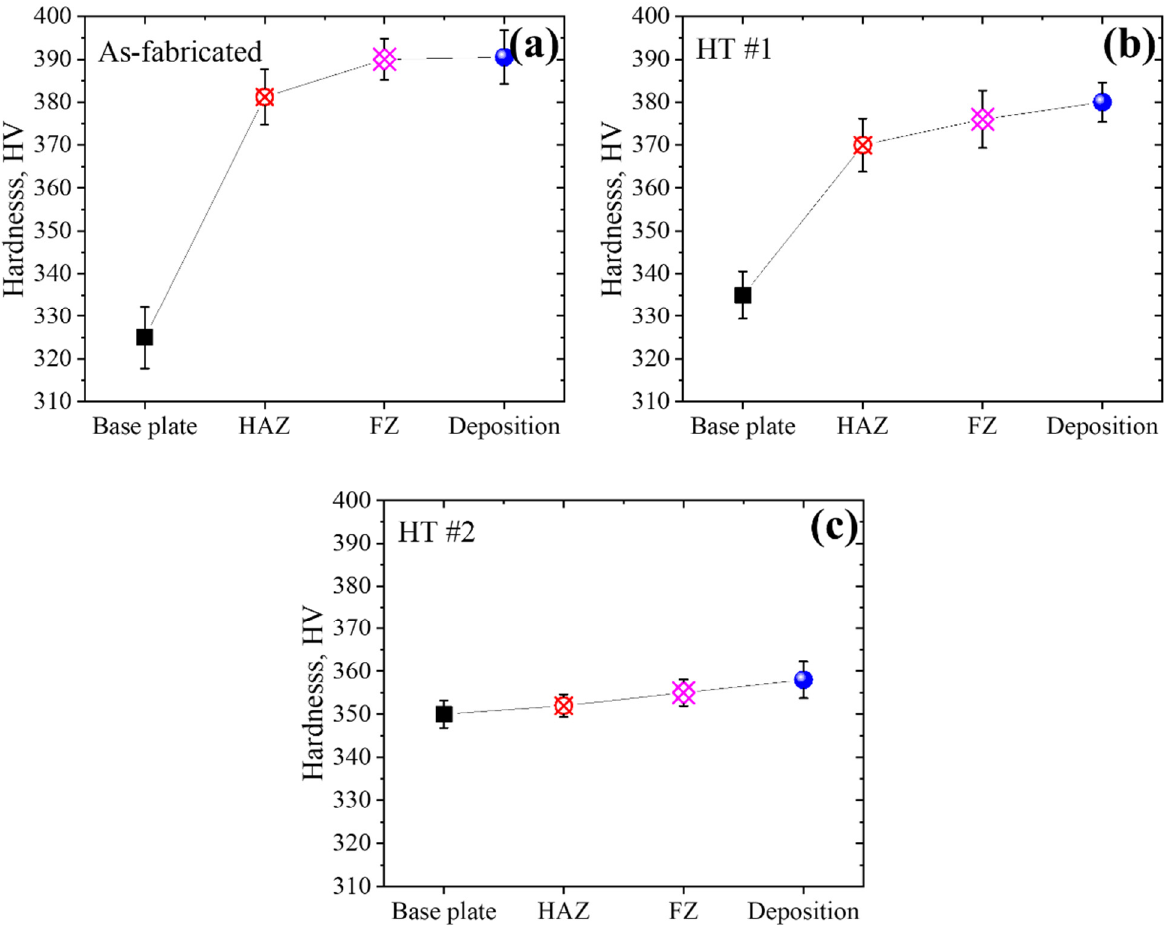
Figure 12. Variation in the hardness of the deposition region, heat-affected zone (HAZ), and base plate after direct energy deposition processing of the Ti–6Al–4V alloy: ( a ) as-fabricated, ( b ) HT #1, and ( c ) HT